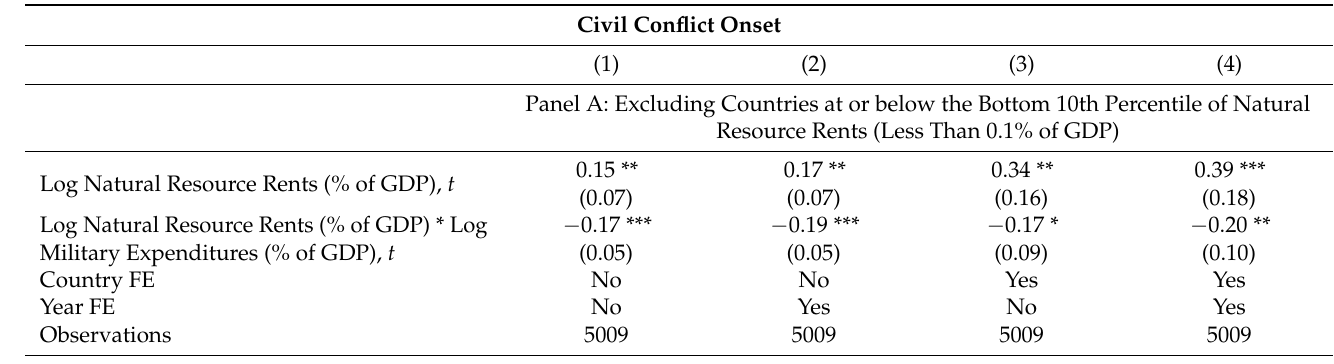
Table 6. Robustness: Excluding Countries with Very Low Military Expenditures or Very Low Natural Resource Rents. Civil Conflict Onset Panel A: Excluding Countries at or below the Bottom 10th Percentile of Natural Resource Rents (Less Than 0.1% of GDP)